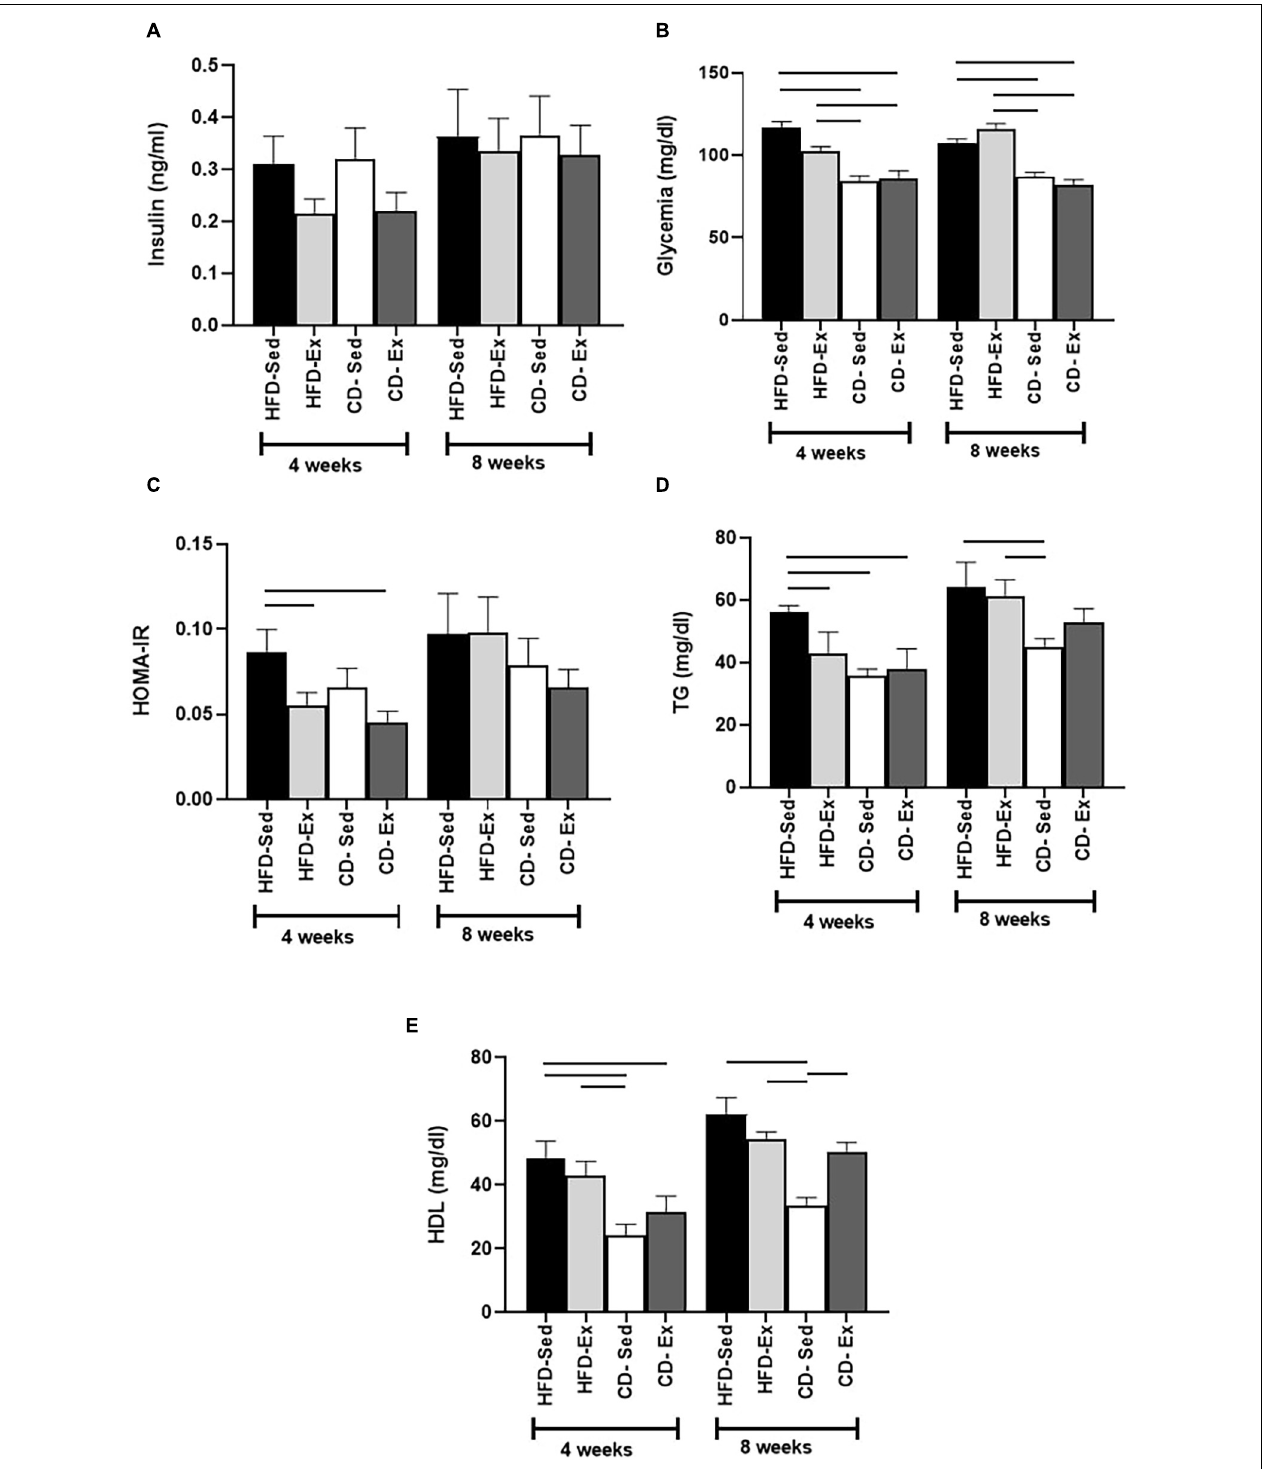
FIGURE 5 | Effects of diet and exercise on body composition on biochemical parameters. (A) Serum insulin concentration after 4 and 8 weeks of dietary and training interventions. (B) Blood glucose after 4 and 8 weeks of dietary and training interventions. (C) HOMA-IR index after 4 and 8 weeks of dietary and training interventions. (D) Serum triglycerides levels after 4 and 8 weeks of dietary and training interventions. (E) High-density lipoproteins (HDL) levels after 4 and 8 weeks of dietary and training interventions. HFD-Sed: sedentary high-fat diet; CD-Ex: chow diet and exercise; CD-Sed: sedentary chow diet. The bars represent the significant differences between the groups indicated. Results are means ± SEM ( p <